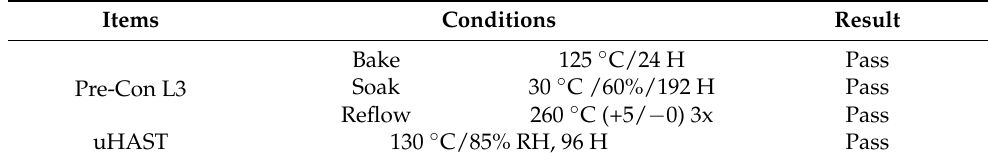
Table 3. Results of reliability